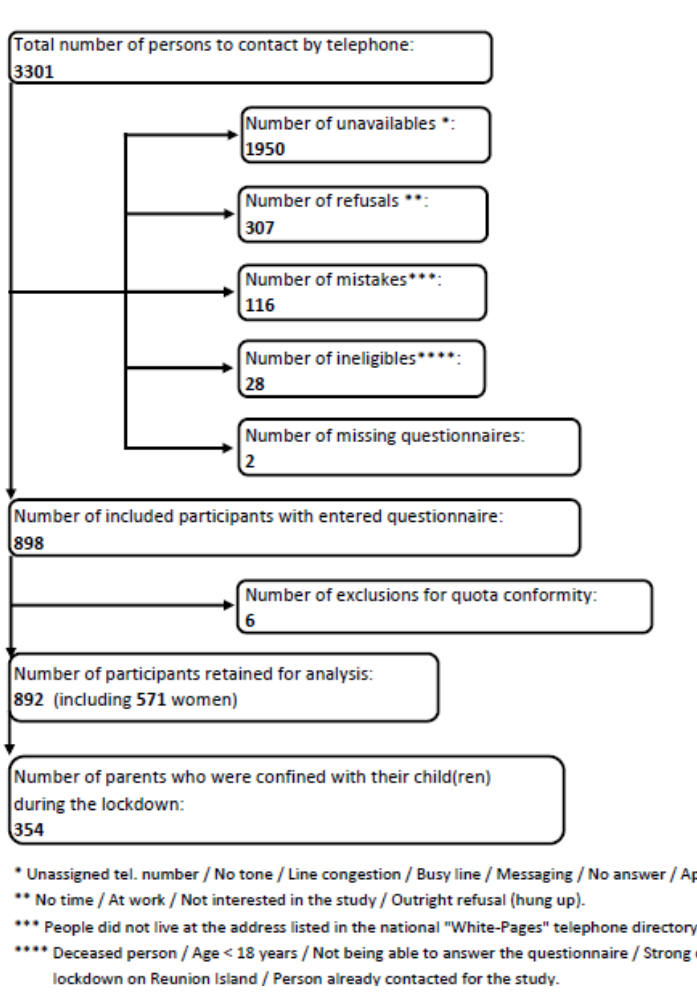
Figure A1. Flowchart of the participant selection process, Ré-Conf-ISS cross-sectional study (Reun-